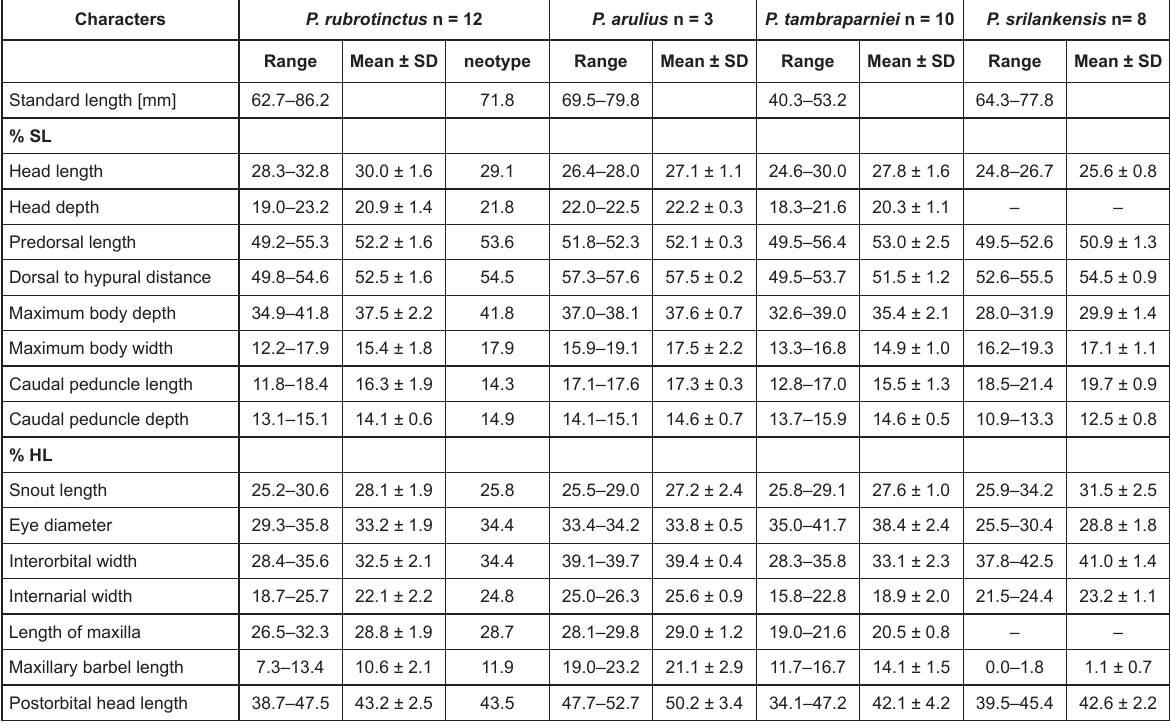
Table 1. Morphometric data of P. rubrotinctus (ZSI/SRS F.8373; ZSI/WGRC F.5077 and F.3954), P. arulius (ATREE unregistered), P. tambraparniei (ZSI/SRS F.4452) and P. srilankensis (Pethiyagoda & Kottelat